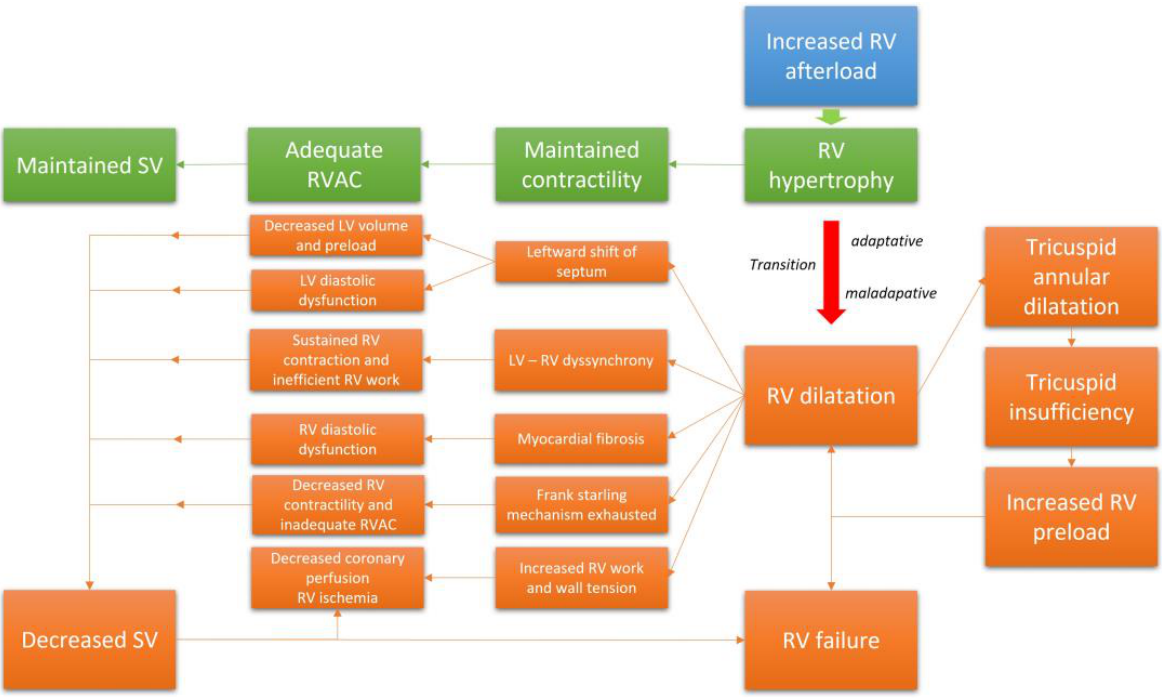
Figure 2. The transition from an adaptative RV phenotype to a maladaptative phenotype.